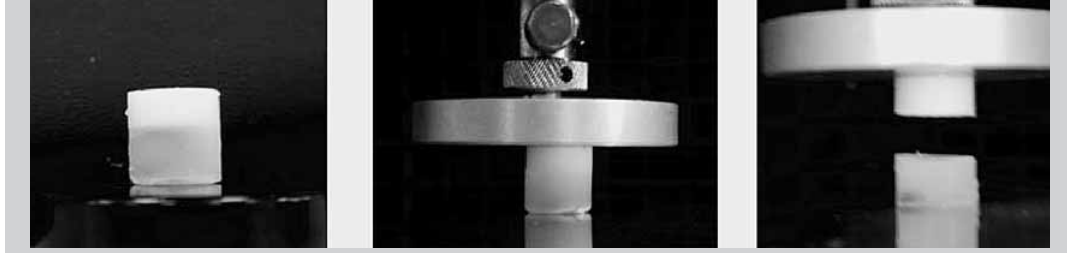
Figure 1: Principle of tensile test for the determination of the interfacial strength between a two layer maltodex- trin/agarose